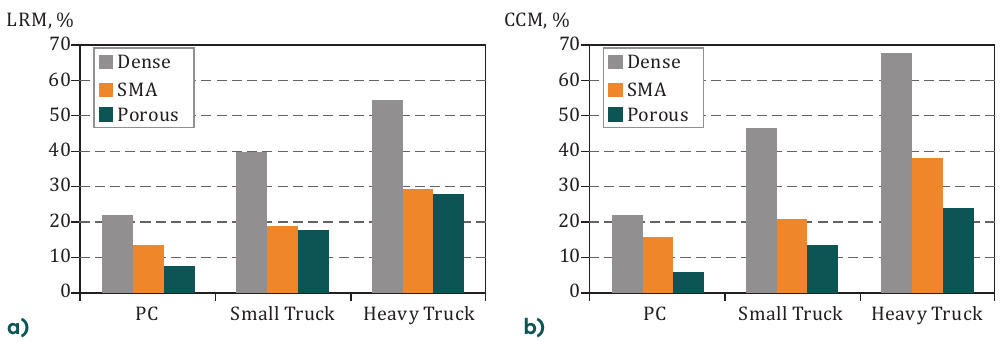
Figure 2. Effect of visibility loss (percentage of light reduction (LRM) and percentage of colour change (CCM)) for each mix type. PC, passenger car (Rungruangvirojn & Kanitpong,